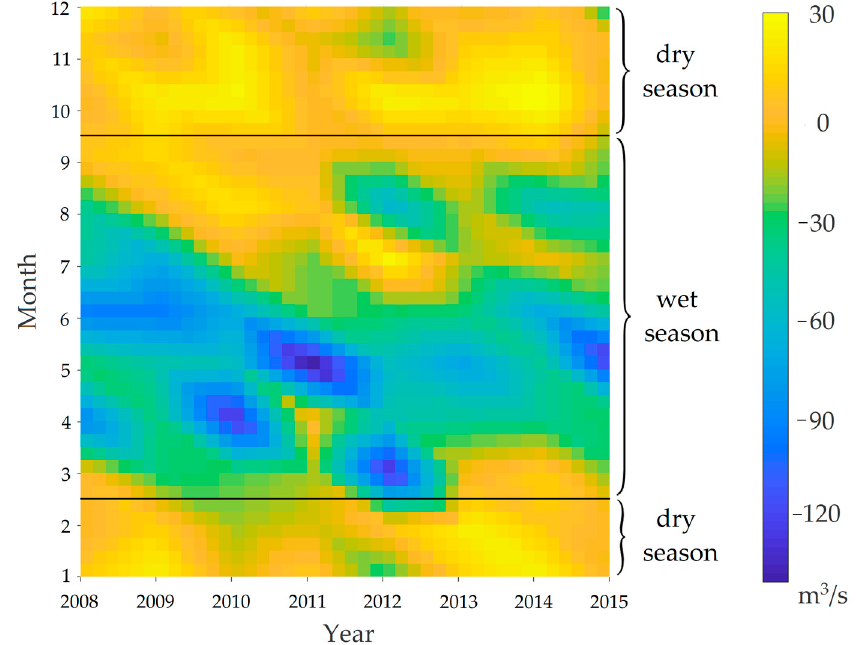
Figure 7. Temporal distribution of reservoir effect on the downstream discharge at Xiashan for 2008–2015. Yellow indicates the streamflow is increased with the consideration of reservoirs whereas blue indicates otherwise (see the color bar).